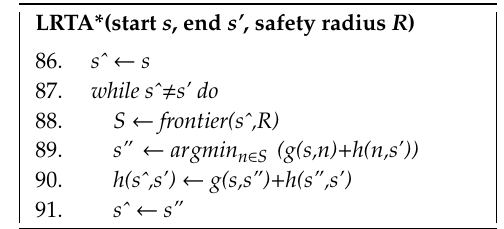
Table 6. The pseudocode for learning real time A* search.